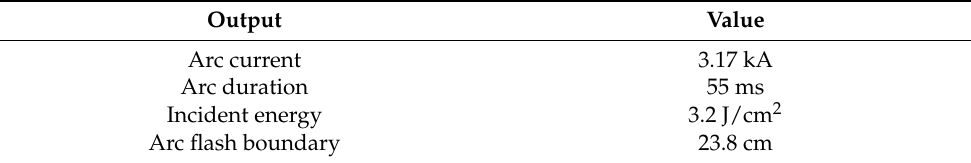
Table 3. ArcPro simulation results summary—Case study 1.